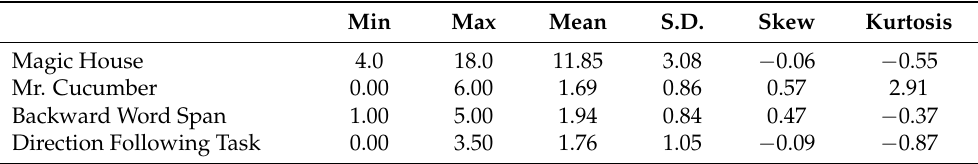
Table 1. Descriptive statistics for updating and working memory capacity